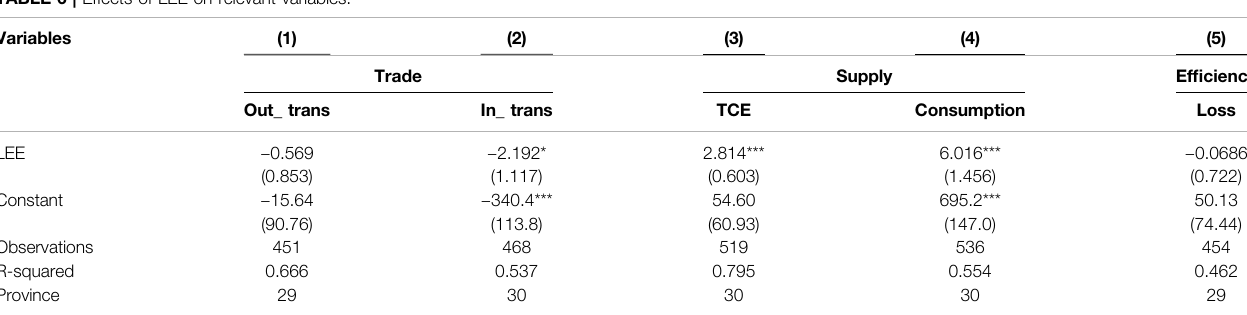
TABLE 6 | Effects of LEE on relevant variables.